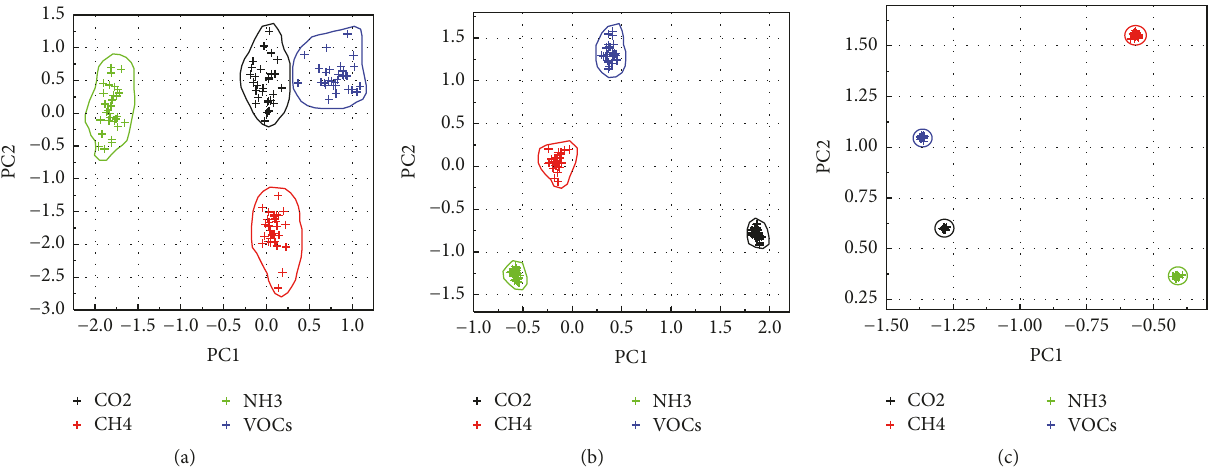
Figure 5: Classification results of SLLE when (a) 𝐾 = 10 , (b) 𝐾 = 20 , and (c) 𝐾 = 30 . The horizontal axis represents the feature vector space corresponding to the selected first eigenvalue, and the vertical axis represents the selected second eigenvalue corresponding to the feature space. Both constitute a dimensionality reduction in two-dimensional space.